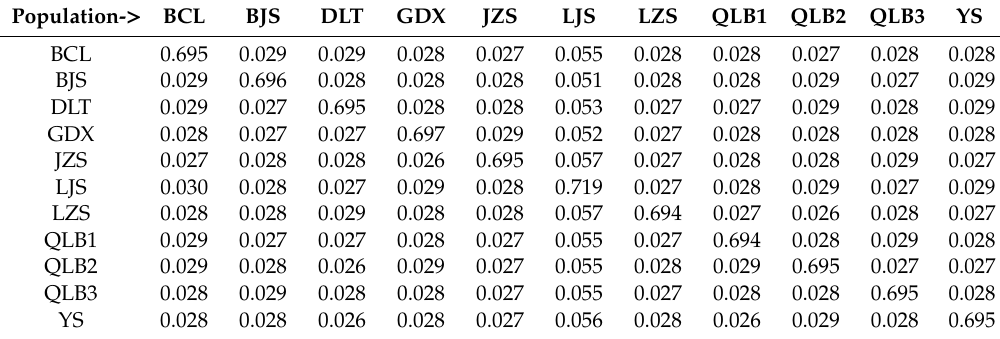
Table 5. Contemporary migration rate between populations of R. rex subsp. rex by BayesAss with 95% confidence